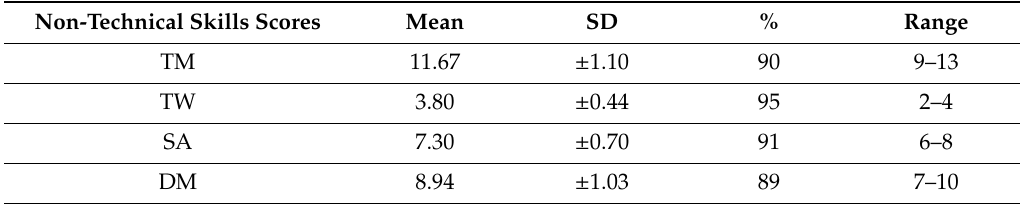
Table 2. Non-technical Skills